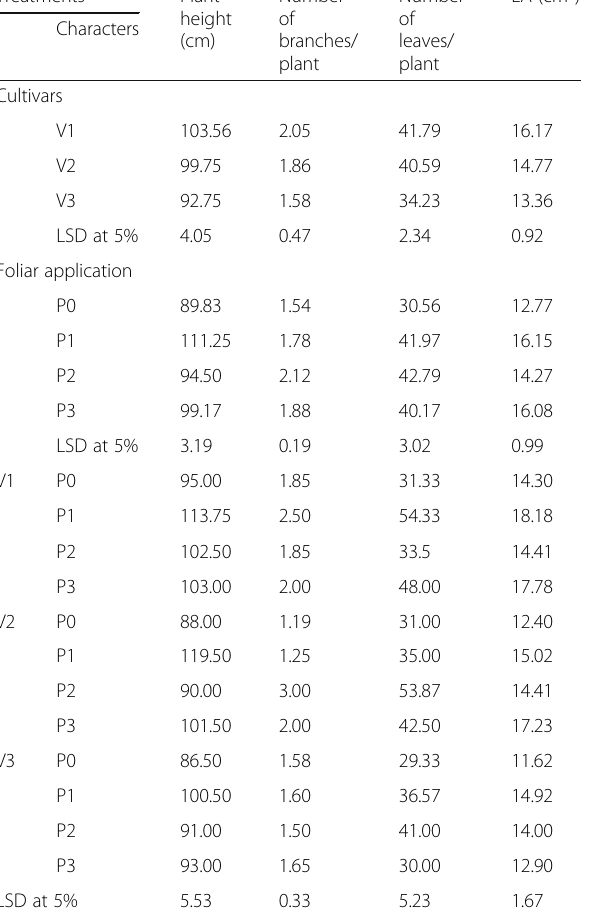
Table 2 Effect of cultivars, foliar application of garlic extract, ascorbic acid or nicotinamide and interactions on growth parameters of faba bean plants (data are means of two seasons) Treatments